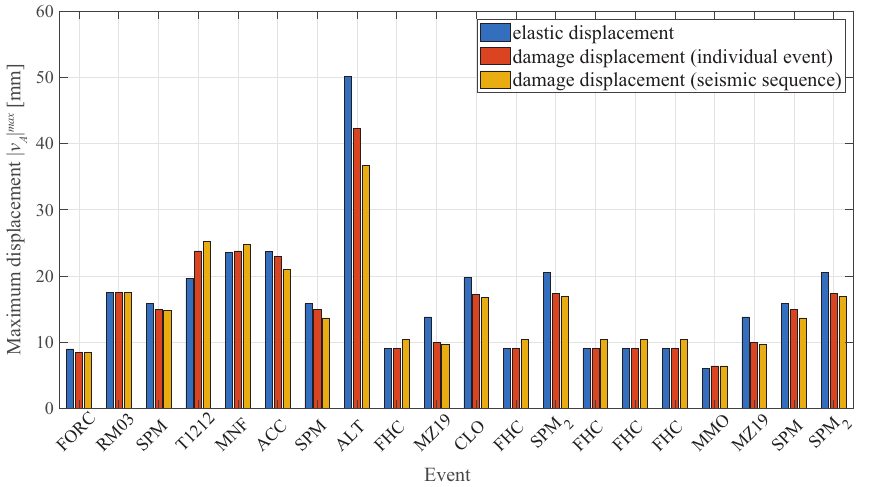
Figure 22. Comparison between maximum displacements obtained for each record in case of elastic response (blue bars) and damage response, considering individual events (red bars) and seismic sequence (yellow bars).